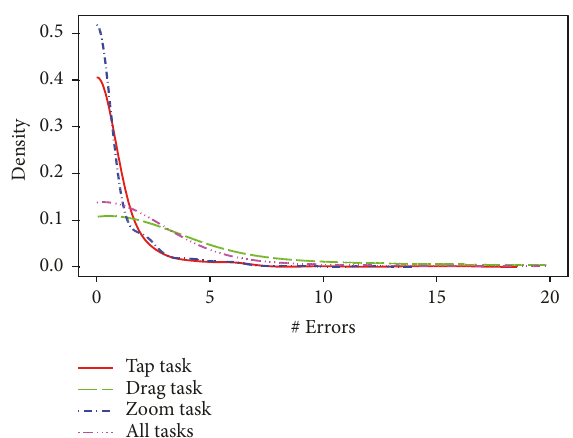
Figure 11: Density distribution of the number of errors for the three task